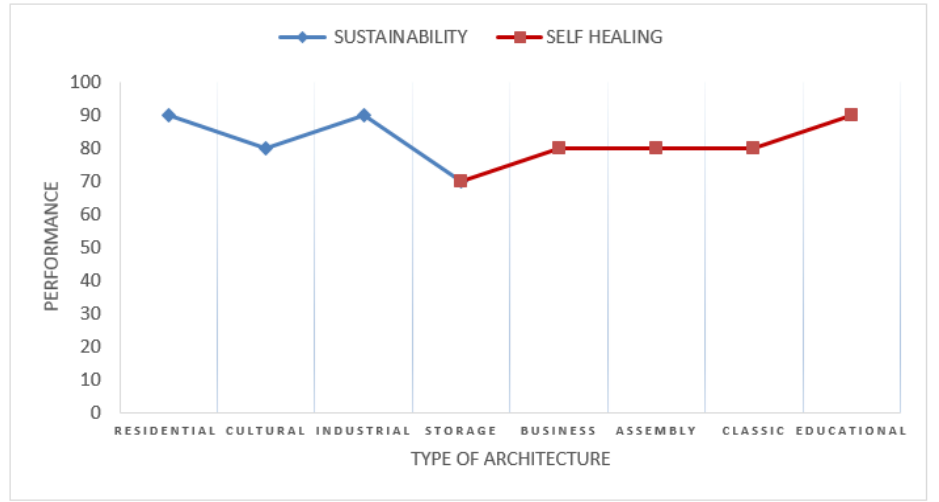
Fig. 8. Different type of architectures being evaluated for sustainability and self-healing mechanism in terms of performance and operation ability factors (by